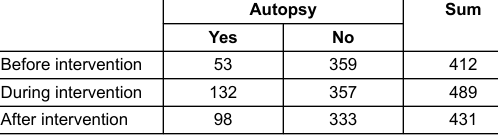
Table 9: Number of deaths and autopsies in 12-month intervals be- fore, during and after the intervention. The difference was statistically highly significant (Fisher’s exact test: p